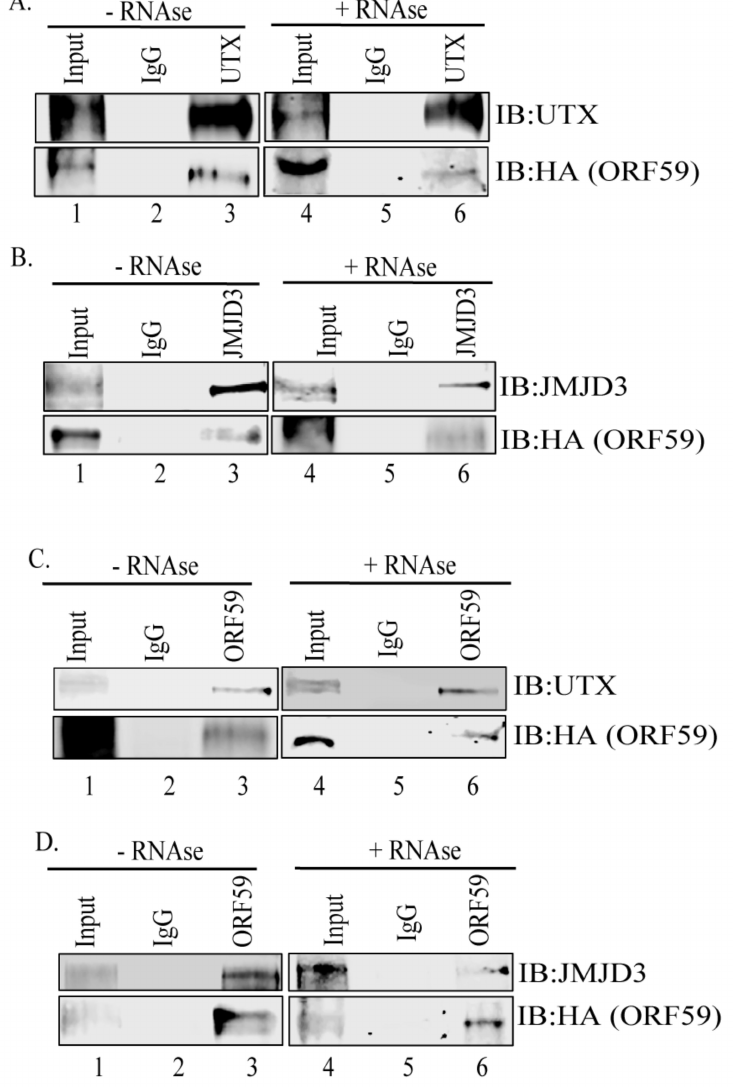
Figure 1. ORF59 binds to H3K27me3-specific demethylases UTX and JMJD3. ( A ) ORF59 was co-precipitated from iSLK / Bac16-ORF59HA cells using anti-UTX antibody (lane 3). Lysates from iSLK / Bac16-ORF59HA cells treated with RNase and precipitated using anti-UTX antibody showed binding between ORF59 and UTX. ( B ) ORF59 co-precipitated from iSLK / Bac16-ORF59HA cells using anti-JMJD3 antibody (lane 3). Lysates from iSLK / Bac16-ORF59HA cells treated with RNase and precipitated using anti-JMJD3 antibodies showed binding between ORF59 and UTX proteins. ( C ) Endogenous UTX protein was co-precipitated from KSHV-positive iSLK / Bac16-ORF59HA cells using anti-ORF59 antibody (lane 3). Lysates from KSHV-positive iSLK / Bac16-ORF59HA cells treated with RNase and precipitated using anti-ORF59 antibody showed binding between ORF59 and UTX. ( D ) JMJD3 protein was co-precipitated from iSLK / Bac16-ORF59HA cells using anti-ORF59 antibody (lane 3), and the lysates treated with RNase also showed binding between ORF59 and JMJD3